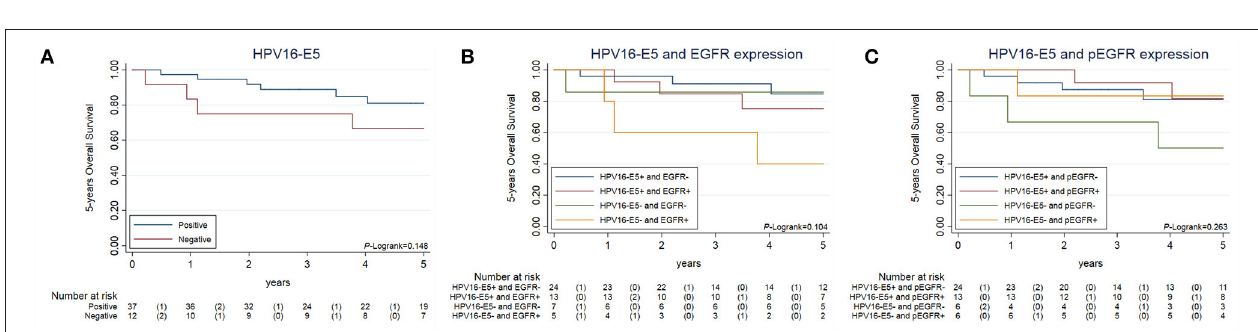
FIGURE 5 | Overall survival of locally-advanced HPV16-related patients stratified by HPV16-E5 alone and in combination with EGFR and pEGFR. Legend: Data on 5 years Overall Survival for HPV16-related patients, stratified by HPV16-E5 (A) the combination of HPV16-E5 and EGFR (B) and the combination of HPV16-E5 and pEGFR (C) . The H0 assumed that all groups have equal